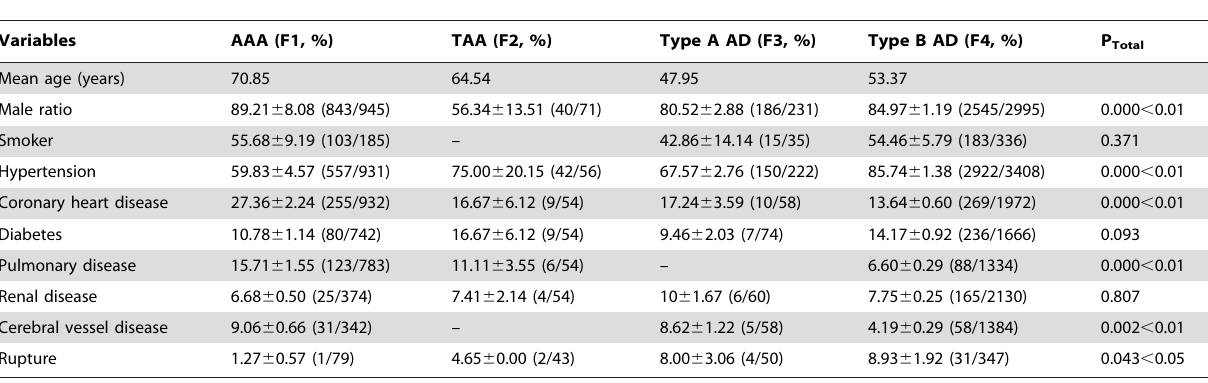
Table 1. Characteristics of patients with aortic diseases.